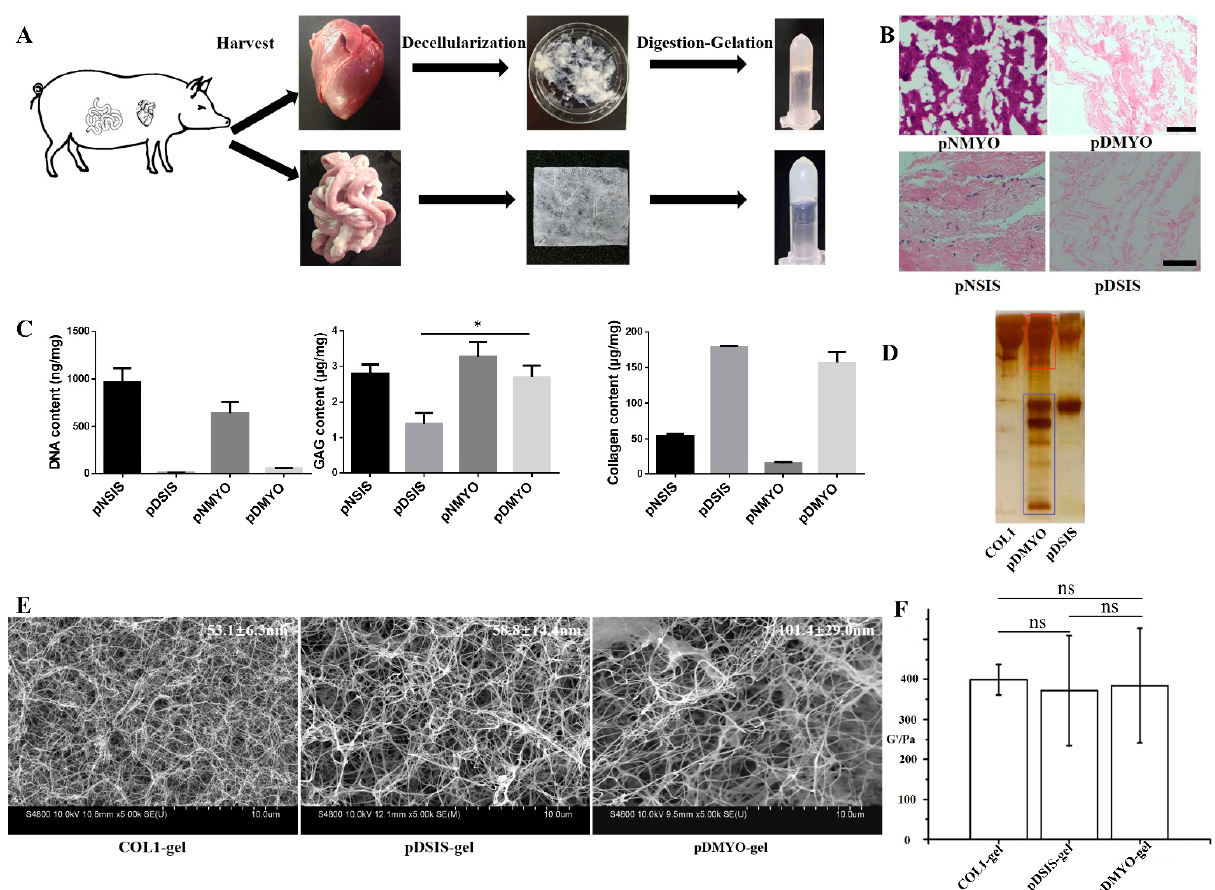
Figure 1. Preparation and properties of pDMYO-, pDSIS-, and COL1-gels. ( A ) Preparation of pDMYO- and pDSIS-gels; ( B ) H&E staining of porcine non-decellularized myocardial matrix (pNMYO) and porcine decellularized myocardial matrix (pDMYO), scale bar = 100 µ m; H&E staining of porcine non-decellularized small intestinal submucosa matrix (pNSIS) and porcine decellularized small intestinal submucosa matrix (pDSIS), scale bar = 50 μ m; ( C ) The contents of DNA, GAG and collagen innon-decellularized and decellularized materials; ( D ) Analysis of protein content in the three gels by SDS-PAGE. ( E ) Comparison of the three gels by scanning electron microscopy; ( F ) Comparison of the elastic modulus of the three gels. * denotes statistical difference within the same group with p < 0.05, respectively ( n = 3).